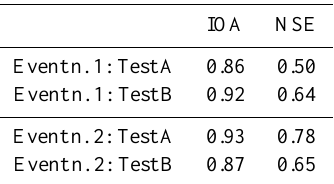
Table 5. Test B: indices of goodness of fit for the calibration and validation